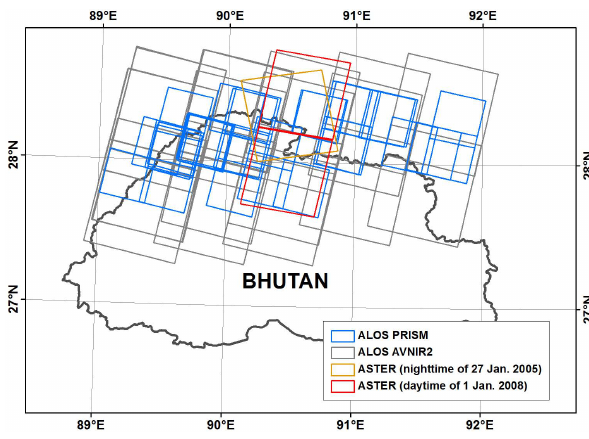
Fig. 2. Coverage areas of satellite data used in this